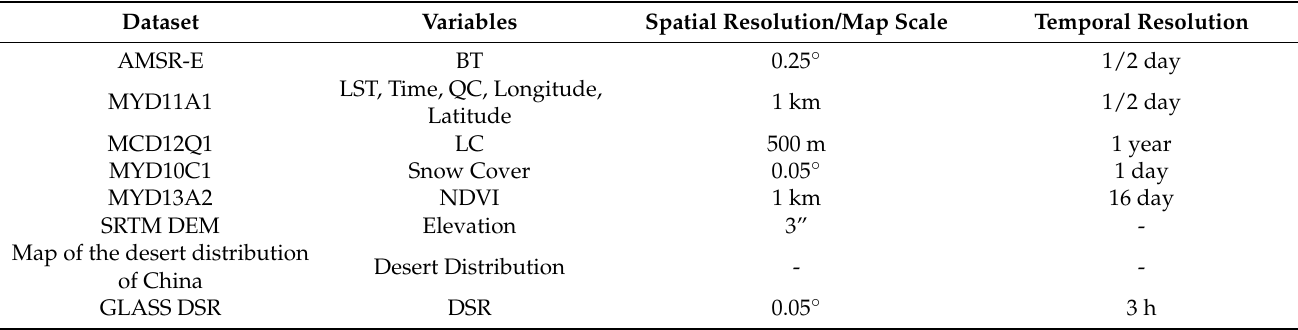
Table 1. Basic information of the datasets used in this study.